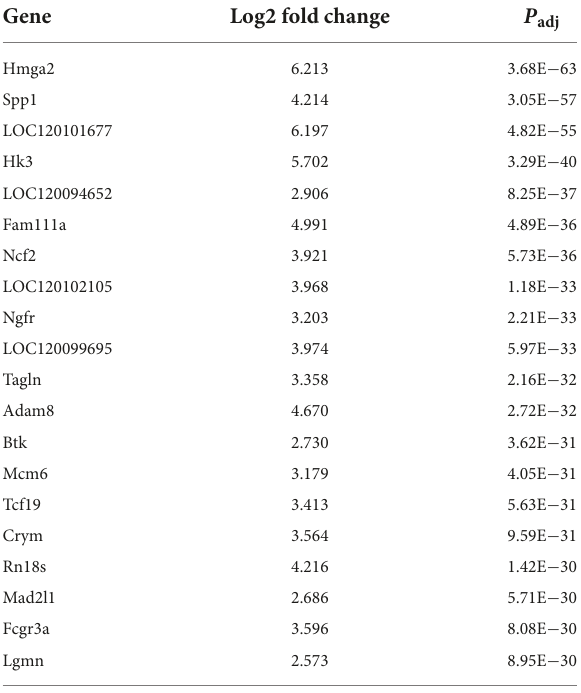
TABLE 4 The top twenty upregulated differentially expressed metabolites (DEGs).